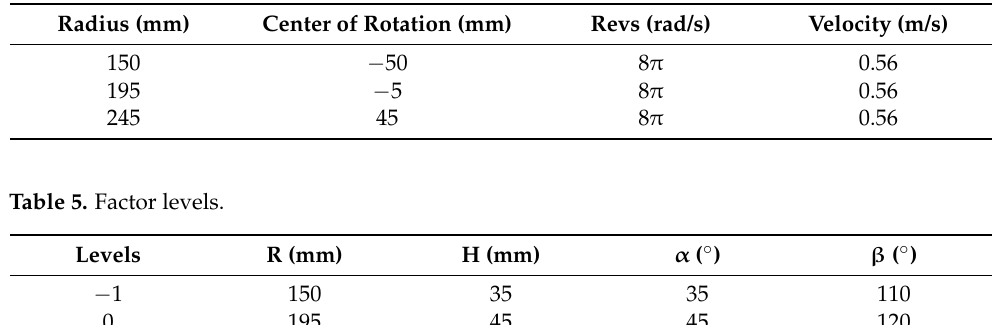
Table 4. Initial conditions.